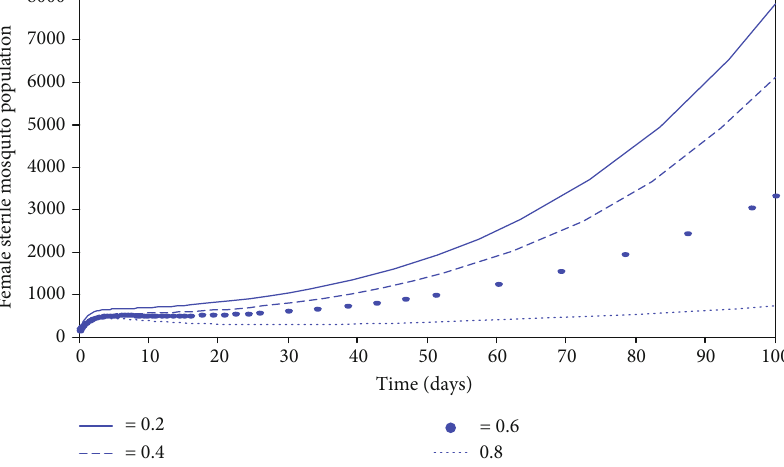
Figure 4: Impact of female mosquito mating probability ð ρ s Þ to be with the sterile male on the female sterile mosquitoes; as this rate increases, the population of the female sterile mosquitoes is